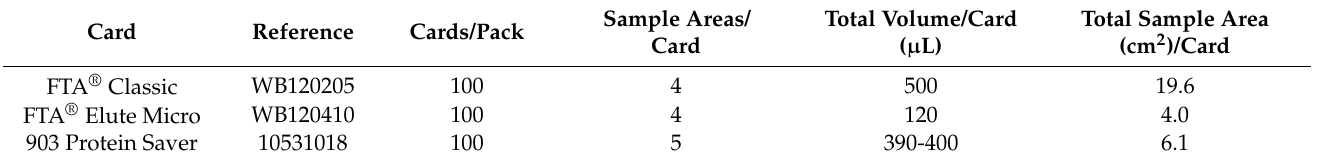
Table 1. Main features of the Whatman ® cards used in the present comparative